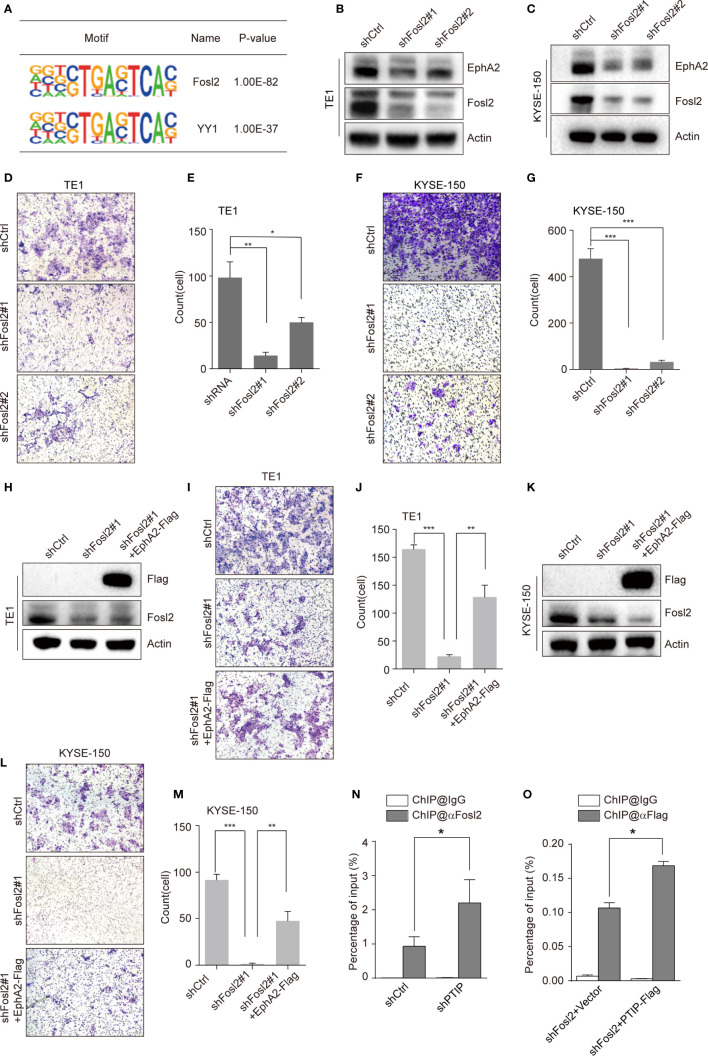
PTIP inhibits EphA2 expression by competing with Fosl2 for binding to EphA2. (A) PTIP highly enriched binding motifs in bioPTIP ChIPseq were identified by HOMER. P-values are indicated within the boxes. (B, C) Western blot analysis of Fosl2 and EphA2 expression in Fosl2 knockdown (shFosl2#1, shFosl2#2) and control (shCtrl) TE1 (B) and KYSE-150 (C) cells. (D–G) The effect of Fosl2 knockdown on the invasiveness of TE1 (D, E) and KYSE-150 (F, G) cells. For invasion assay, six different microscopic fields (magnification, ×10) from at least three independent experiments were examined; Relative intensities of the fields were measured (n≥3). Representative images and statistical plots are shown; Mean ± s.d. are given for three independent experiments. One-way ANOVA; *P < 0.05; *P < 0.01; ***P < 0.001. (H–M) Western blot showing stable expression of Flag-EphA2 in shFosl2#1 TE1 cells (H) and KYSE-150 cells (K). Overexpression EphA2 partially restored TE1 cells (I, J) and KYSE-150 cells (L, M) invasive ability, which attenuated by depletion of Fosl2. For invasion assay, six different microscopic fields (magnification, ×10) from at least three independent experiments were examined; Relative intensities of the fields were measured (n≥3). Representative images and statistical plots are shown; Mean ± s.d. are given for three independent experiments. One-way ANOVA; *P < 0.05; ***P < 0.001. (N, O) ChIP-qPCR analyses of the relationship between Fosl2 and PTIP in transcriptional regulation for EphA2. Mean ± s.d. are given for three independent experiments. Unpaired, two-tailed Student’s t-test; *P < 0.05.